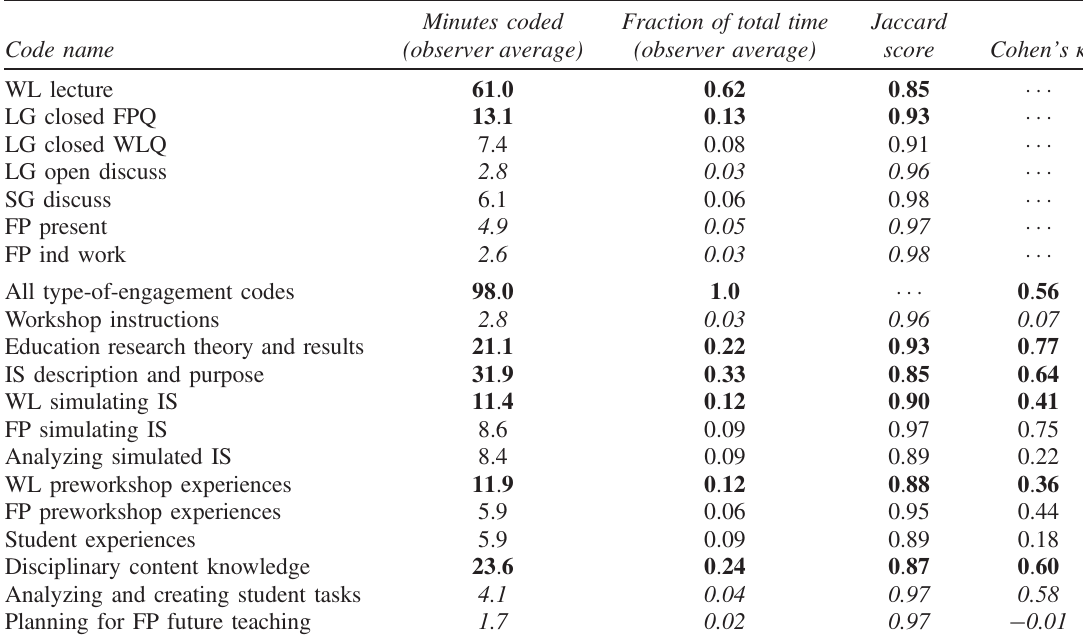
TABLE IV. Results of interrater reliability testing for the authors, measured with the Jaccard similarity score in all cases and Cohen ’ s κ when appropriate. These calculations include 98 min of data comprised of 7, 5 – 30 minute segments of NFW sessions. Results for codes that were selected for more than 10% of the total time coded are in bold, and results for codes that were selected for less than 5% of the time are italicized. As justified in Sec. VA, we calculate a single value of Cohen ’ s κ for the type-of-engagement codes, and separate values for each focus-of- engagement